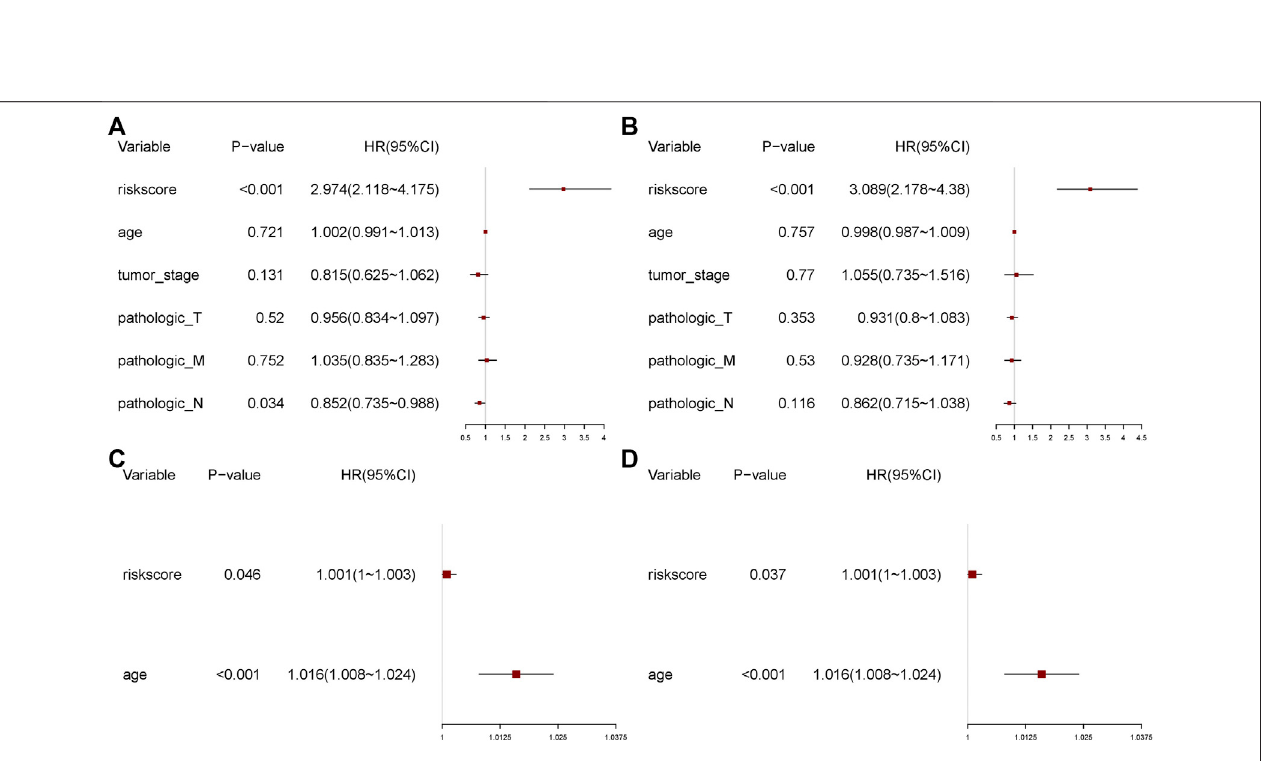
FIGURE 11 | Univariate and multivariate regression analyses. (A) Univariate analysis. (B) Multivariate analysis. (C) Univariate analysis of the validation set. (D) Multivariate analysis of the validation